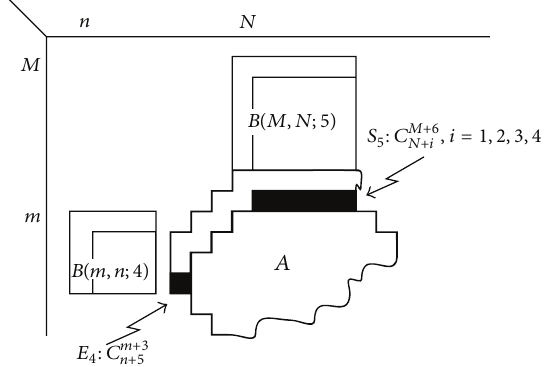
Figure 5: Intersection of two shadow regions in the 𝑐 -table.